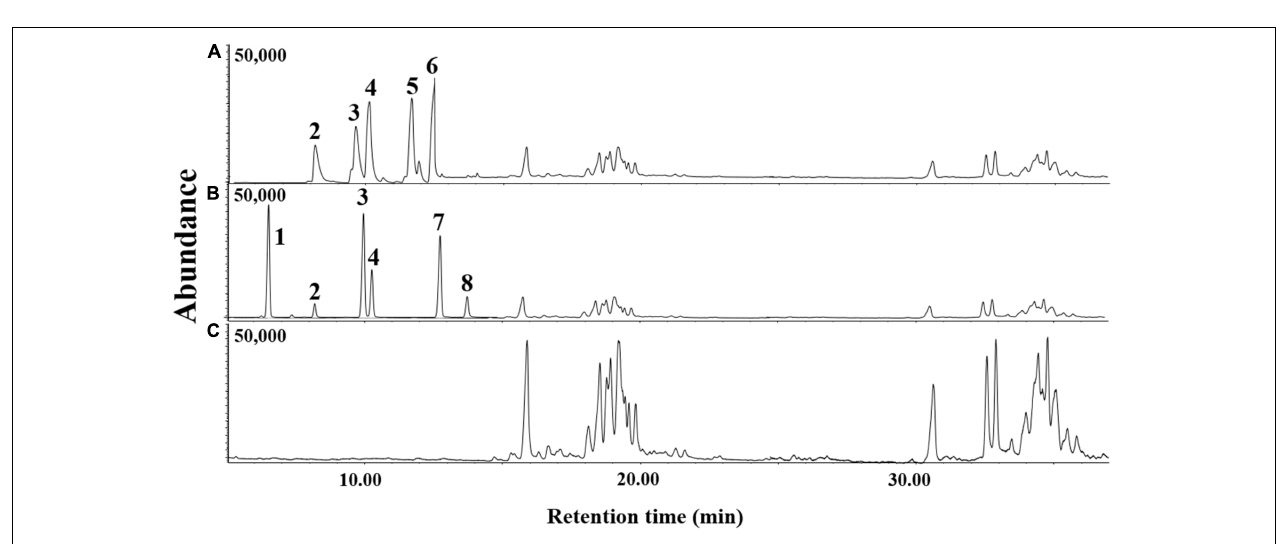
FIGURE 6 | FTIR spectra of culture supernatant of E. clematidis (C) , and A. niger (B) in the presence of Impranil as sole carbon source, and Impranil liquid medium without culturing of fungi (A) after 2-week inoculation.